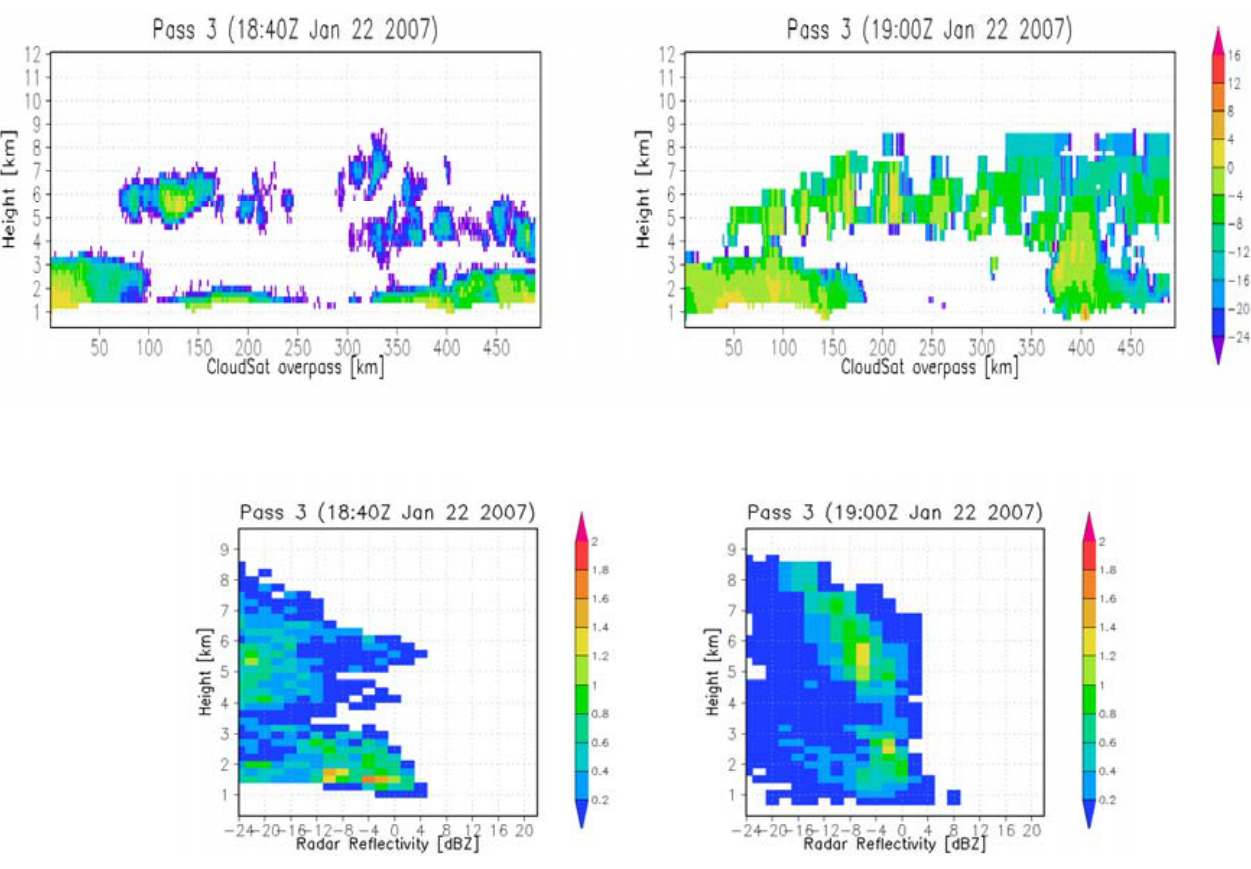
Fig. 6. (a) Instantaneous cross-sectional snap shot (upper panel) and (b) contoured frequency with altitude diagrams (CFADs) (lower panel) of CloudSAT-observed (left) and WRF-SDSU-simulated (right) Cloud Profiling Radar (CPR, 94GHz) reflectivities.